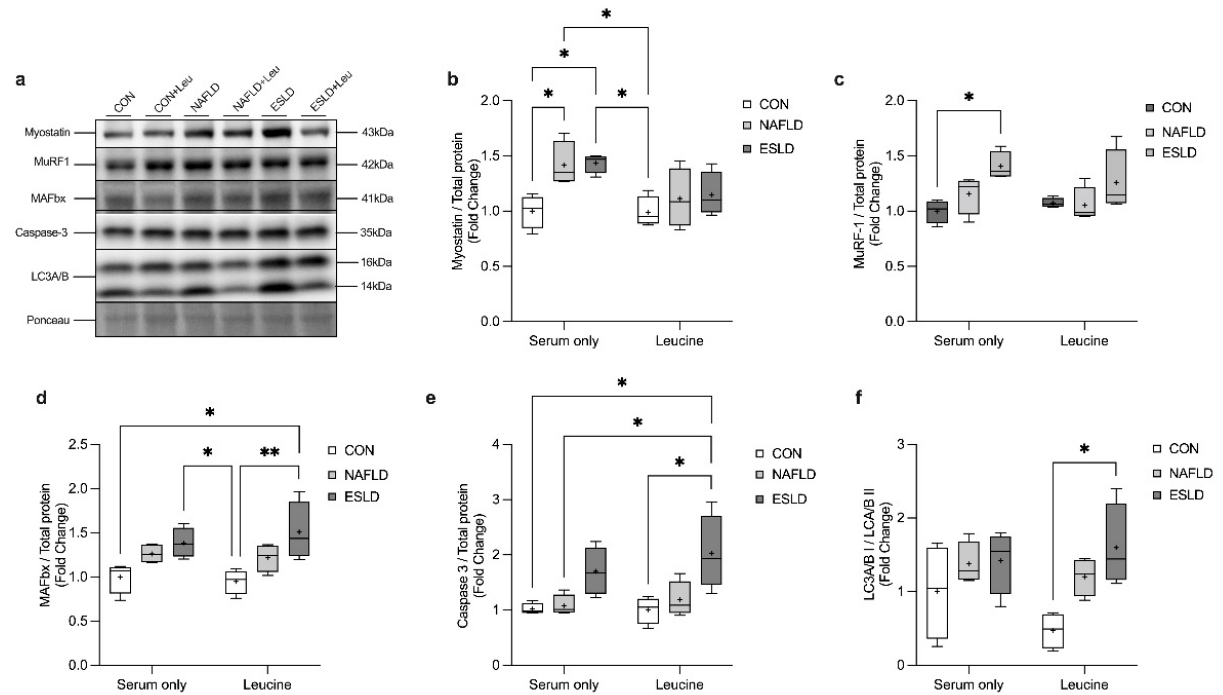
Figure 3. Markers of catabolic signaling are elevated within myotubes treated with serum from ESLD patients for 4 h and a 30 min treatment with leucine. Myotubes were treated with ex vivo human serum from age-matched control (CON), non-alcoholic fatty liver disease (NAFLD) and end stage liver disease (ESLD) patients for 4-h, with and without a 30-min treatment with 5 mM leucine. ( a ) Representative western blot images of catabolic signaling markers, ( b ) myostatin, ( c ) MAFbx, ( d ) MuRF-1, ( e ) caspase-3, ( f ) LC3A/B. Data are expressed as fold change in comparison to the CON. Data are expressed as the mean (cross), median (central horizontal line), 25th and 75th percentiles (box) and the minimum and maximum values (vertical lines), with n = 4 per group and each data point corresponding to the average of 3 technical repeats. * p < 0.05, ** p <